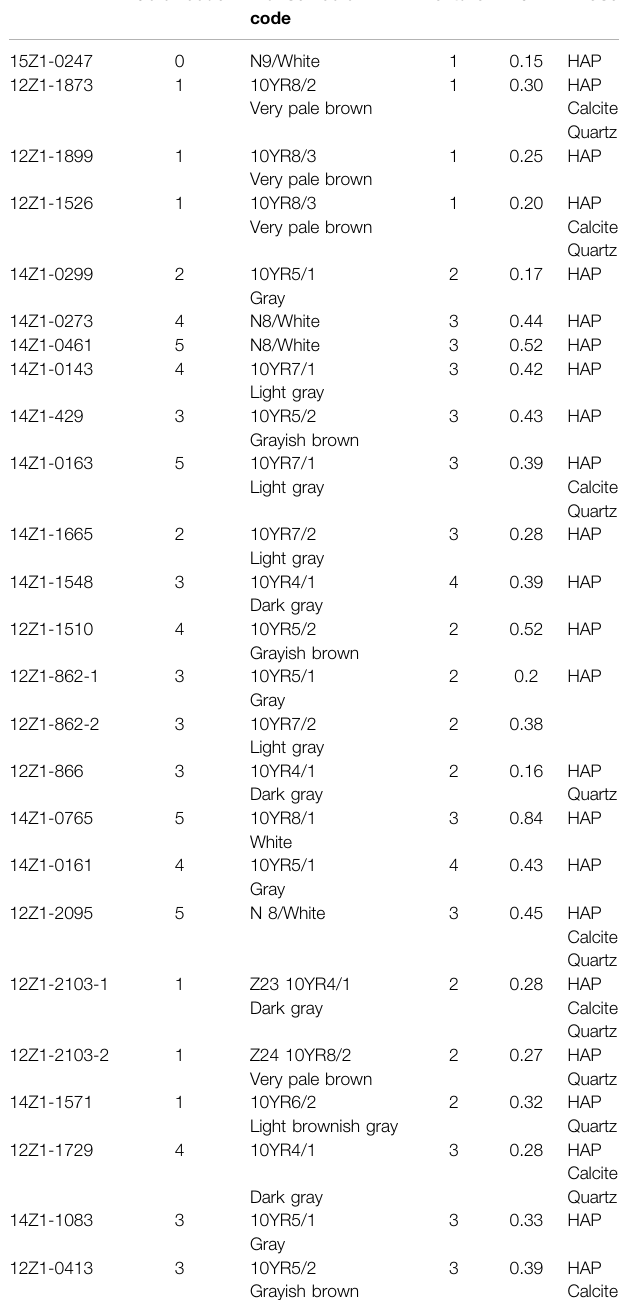
TABLE 3 | Results from macroscopic observation and XRD